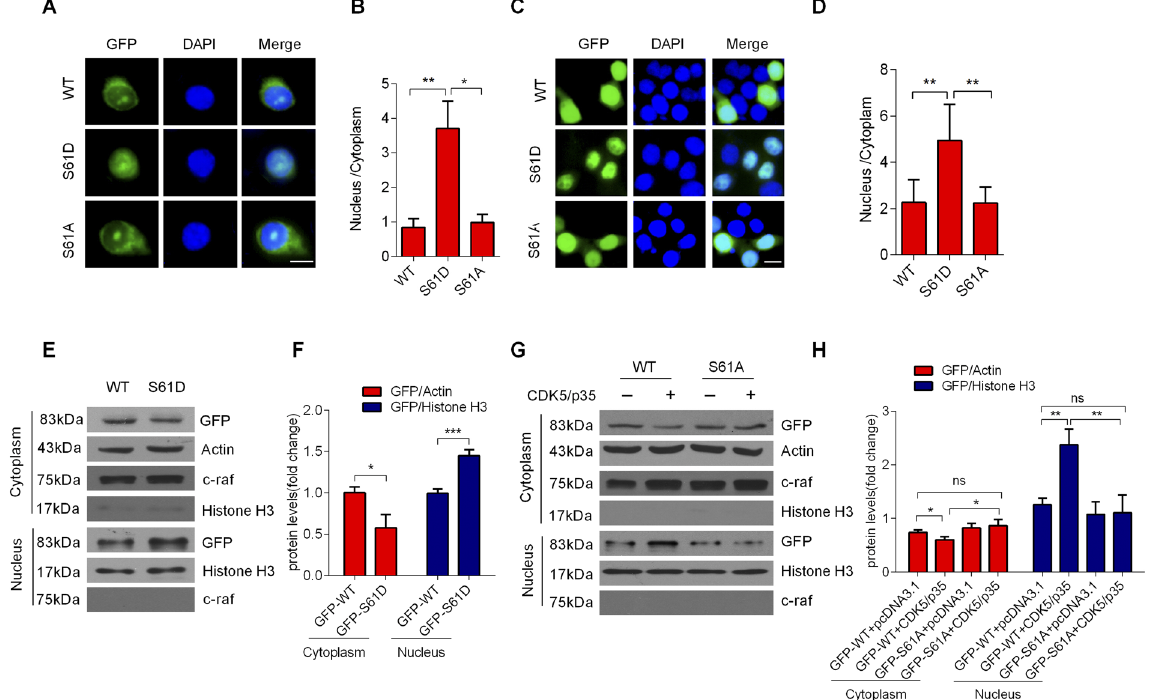
Figure 4. Phosphorylation of XBP1s at Ser61 facilitates its nuclear translocation. Mutation of Ser61 to Asp (S61D) enhanced the nuclear translocation of XBP1s in neurons ( A ) and HEK293 cells ( C ) transiently transfected with GFP-XBP1s-WT, GFP-XBP1s-S61A mutation or GFP-XBP1s-S61D mutation. Statistical analysis of the fluorescent intensity of nucleus/cytoplasm in neurons ( B ) and HEK293 cells ( D ) transfected with GFP-XBP1s-WT, GFP-XBP1s-S61A mutation or GFP-XBP1s-S61D mutation. ( E ) Mutation of S61D enhanced the nuclear translocation of XBP1s. The expression levels of GFP-XBP1s protein in cytoplasmic and nuclear lysates from HEK293 cells transfected with GFP-XBP1s-WT or GFP-XBP1s-S61D were detected by immunoblotting. ( F ) Statistical analysis of the expression of GST-XBP1s WT or S61D proteins in cytoplasmic and nuclear lysates from HEK293 cells transfected with GFP-XBP1s-WT or GFP-XBP1s-S61D plasmids. ( G ) CDK5/p35 enhanced the nuclear translocation of GFP-XBP1s-WT but not GFP-XBP1s-S61A in HEK293 cells. HEK293 cells were co-transfected with HA-CDK5/Myc-p35 and GFP-XBP1s-WT or GFP-XBP1s-S61A plasmids, and then collected and analyzed 24 h after transfection. ( H ) Statistical analysis of the expression of GST-XBP1s WT or S61A proteins in cytoplasmic and nuclear lysates from HEK293 cells co-transfected with HA-CDK5/Myc-p35 and GFP-XBP1s-WT or GFP-XBP1s-S61A. The membranes were re-probed for c-raf and Actin as markers and loading controls of cytoplasmic fractions respectively, and Histone H3 as markers and loading controls of nuclear fractions. The scale bar represents 10 μ m. Data are mean ± s.d. of n = 3 independent experiments. Significance was determined by unpaired Student’st test ( B , D , F and H ). * P < 0.05, ** P < 0.01, *** P <